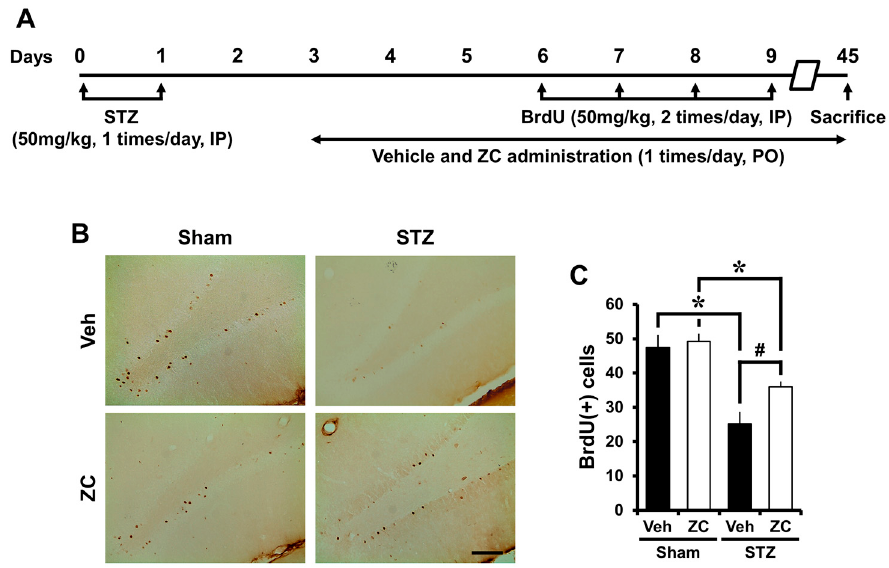
Figure 4. ZC increases survival of BrdU-positive cells in the late phase of STZ-induced diabetic rats. ( A ) Experimental procedure in the late phase of STZ-induced diabetic rats; ( B ) Bright field photomicrographs show surviving newborn cells. In the late phase, the STZ-injected group showed a significant decrease of BrdU (+) cells. However, ZC treatment by gavage for six weeks after STZ-induced hyperglycemia significantly increased BrdU (+) cells. Scale bar = 100 µm; ( C ) Bar graph represents BrdU-positive cells in the SGZ/GCL. Data are means ± SE, n = 6–8 from each group. * p < 0.05, versus sham group; # p < 0.05, versus vehicle-treated STZ group.